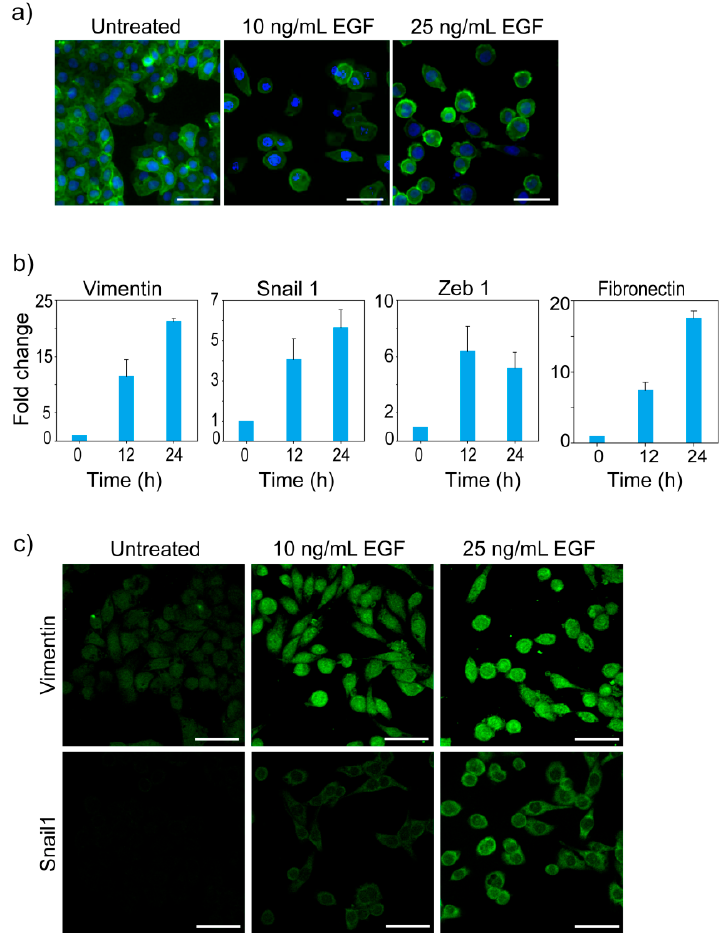
Figure 1. EGF induces EMT in MDA-MB-468 cells. ( a ) Cytoskeletal reorganization and change in morphology. After 24 h treatment with different doses of EGF, cells were stained with Phalloidin and DAPI. Green and blue colors represent the cytoskeleton and DNA content respectively. ( b ) Expression profile of EMT related genes. Cells were treated with 10 ng/mL of EGF and the fold change in expression was measured by qPCR. Averages of three measurements are shown with error bar representing standard deviation. Observed changes in expression of all the genes were statistically significant (Kruskal-Wallis analysis of variance, p < 0.01). ( c ) Immunofluorescence imaging of Vimentin and Snail1. Cells were treated with different doses of EGF for 24 h and stained with Fluorescent-dye conjugated anti-Vimentin and anti-Snail1 antibodies. Scale bar in images: 50 µm.